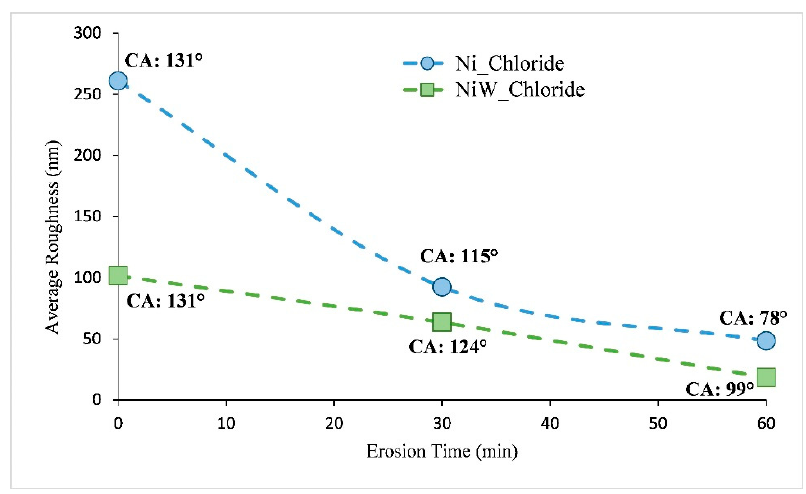
Figure 11. Effect of tungsten on changes in the average roughness of Ni [19] and NiW coatings.